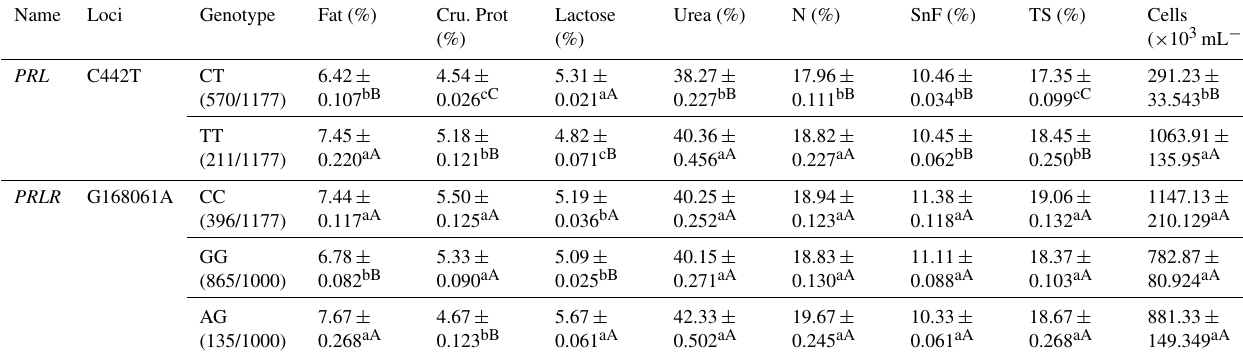
Table A4. Association analysis between PRL and PRLR gene mutation sites and milk production